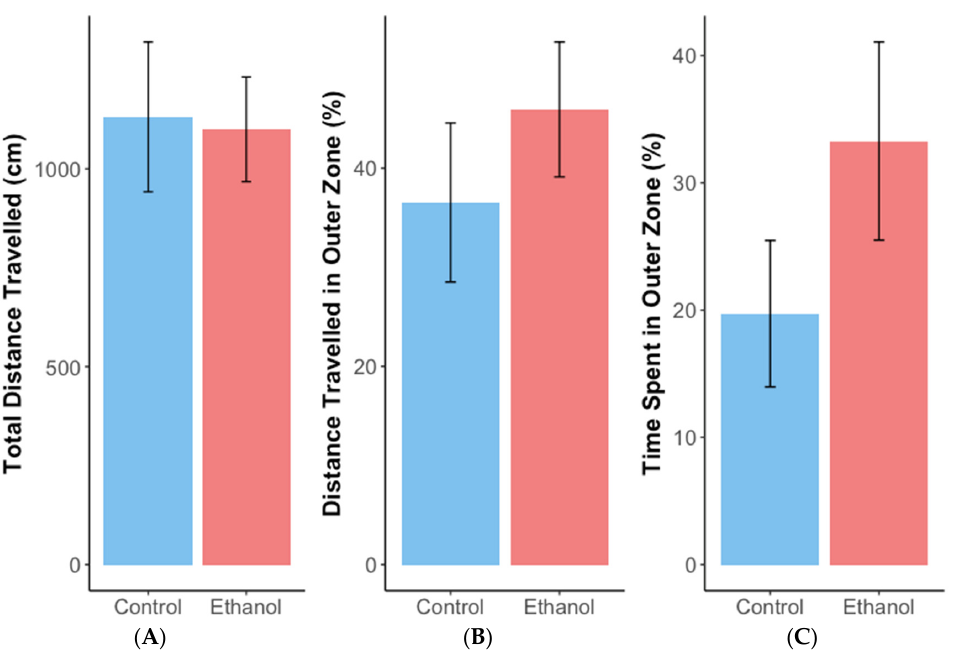
Figure 5. Mean (+/ − SE) distance travelled ( A ), and distance travelled ( B ) and time spent ( C ) in the outer zone as a percentage of the totals for adult female offspring from mothers exposed to ethanol ( n = 14) or water (control) ( n = 7) during the open field test.